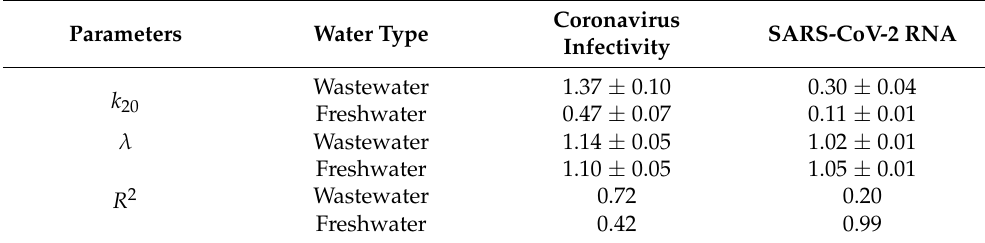
Figure 2. Relationships between decay rate constants of coronavirus and temperatures based on Arrhenius equation (Equation (3)). Arrhenius equation (Equation (3)). Table 4. Parameters in Arrhenius equation fitted by temperatures and decay rates. Table 4. Parameters in Arrhenius equation fitted by temperatures and decay